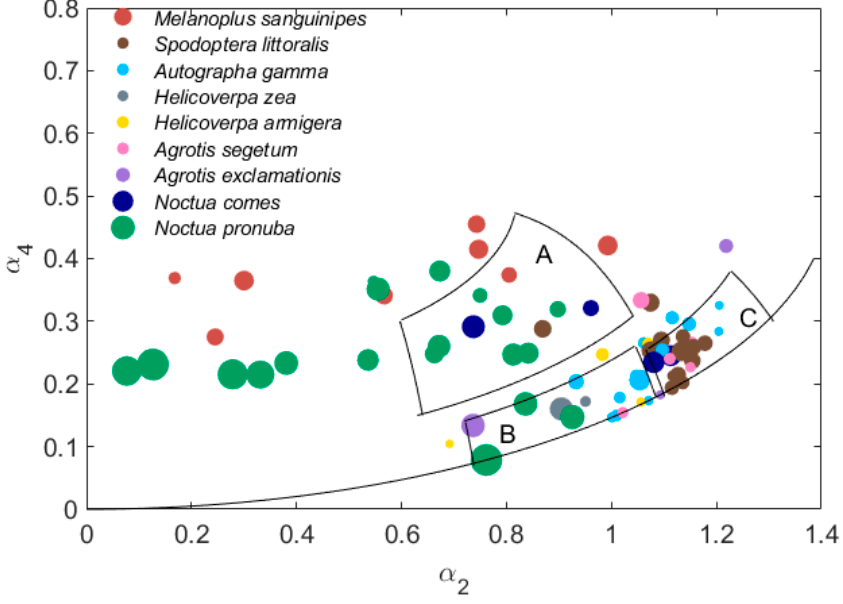
Figure 7. α 2 and α 4 values of possible proxy grasshopper and moth species, from Reference [27]. The size of each dot indicates the mass of each individual insect. Average masses for Melanoplus sanguinipes , Spodoptera littoralis , Autographa gamma , Helicoverpa zea , Helicoverpa armigera , Agrotis segetum , Agrotis exclamationis , Noctua comes , Noctua pronuba are 374 mg, 126 mg, 128 mg, 141 mg, 148 mg, 176 mg, 214 mg, 230 mg and 370 mg, respectively [27]. The three regions plotted are the defined regions for classes A, B and C (Table 2).